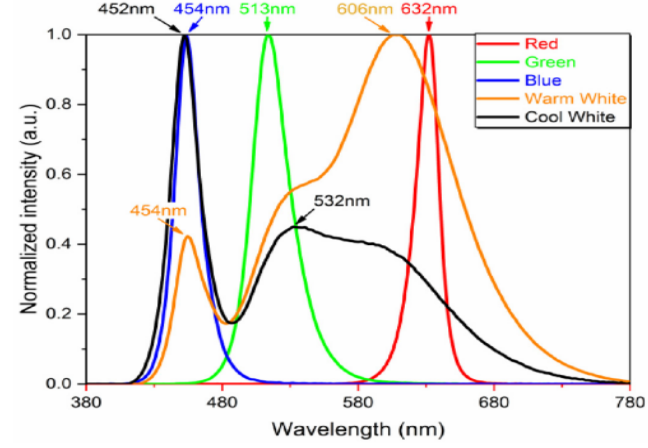
Figure 3. Tunable LED lighting with five channels of RGCWW.